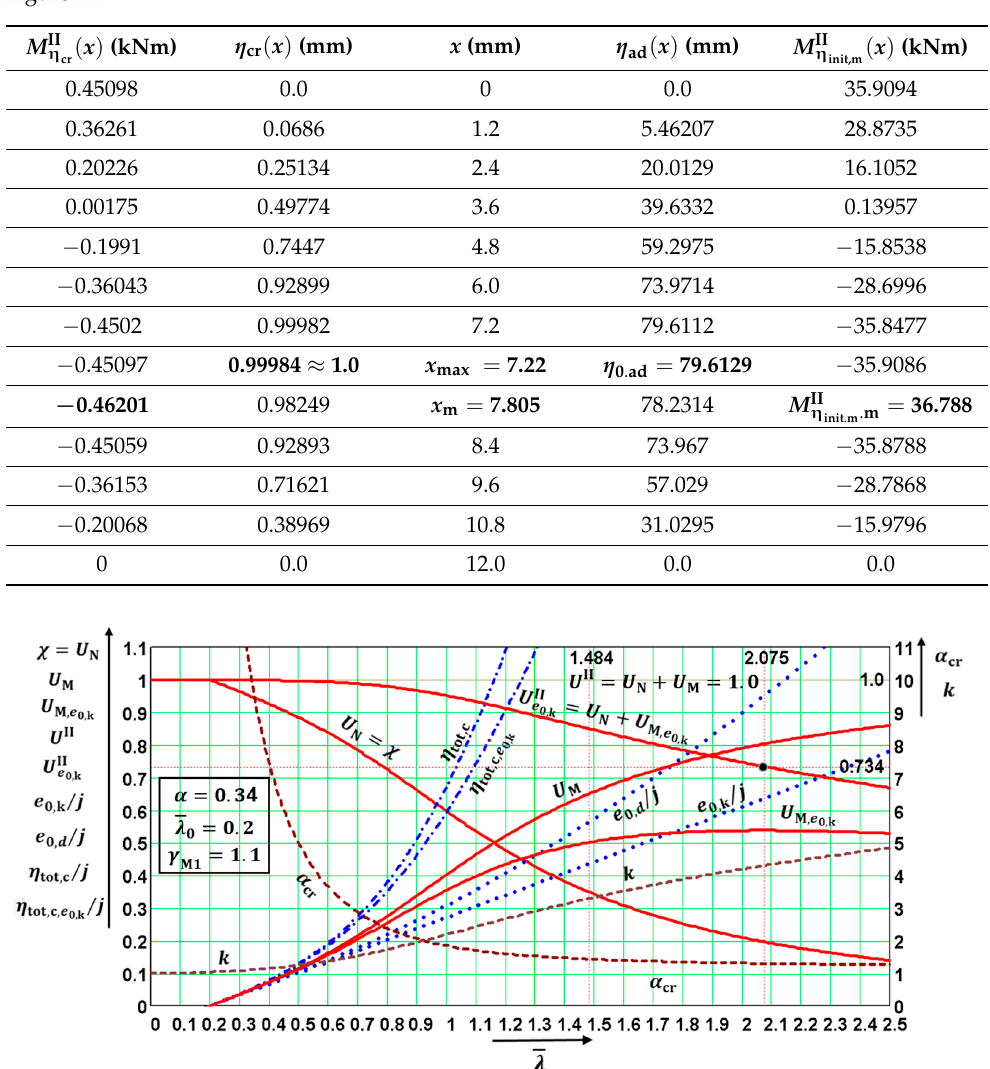
Table 5. Program IQ 100 results. Compare them to the values in Equations (71) and (72), and to Figure 14.